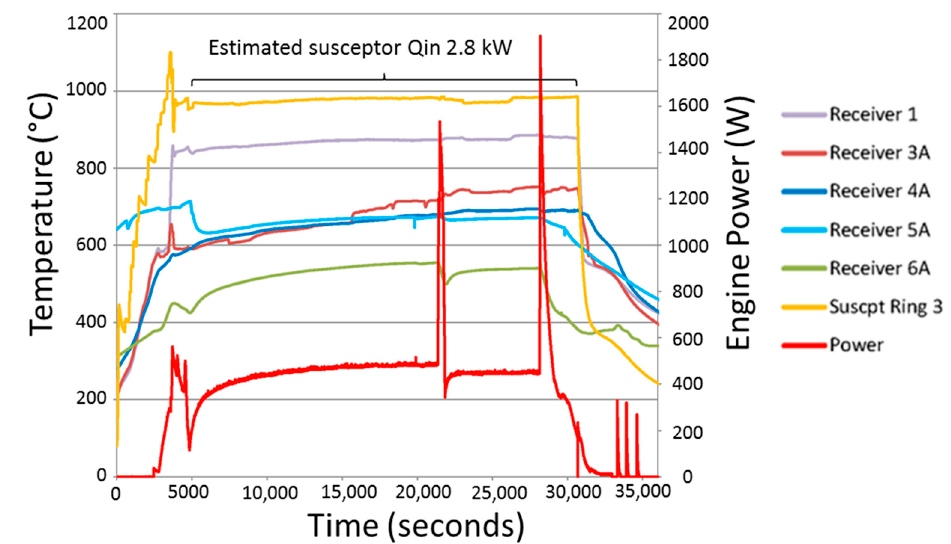
Figure 11. Temperature data and engine power from Phase II testing.